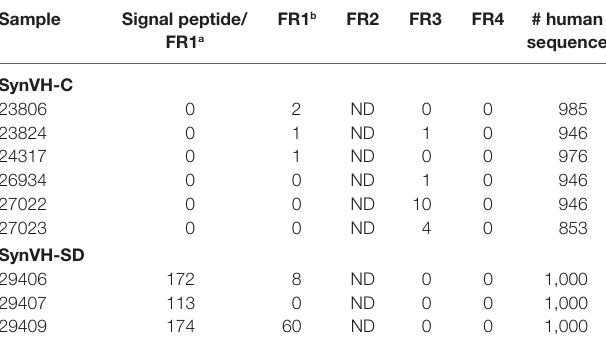
Table 3 | Gene conversion of human FRs by chicken pseudogenes is